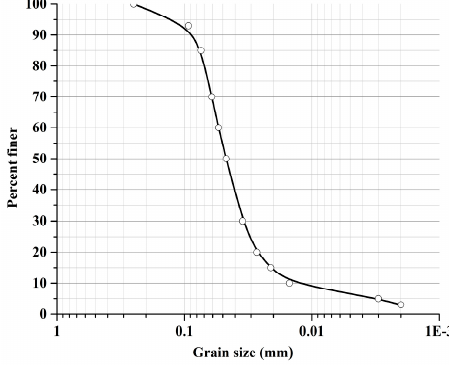
Figure 1. Particle size distribution curve.